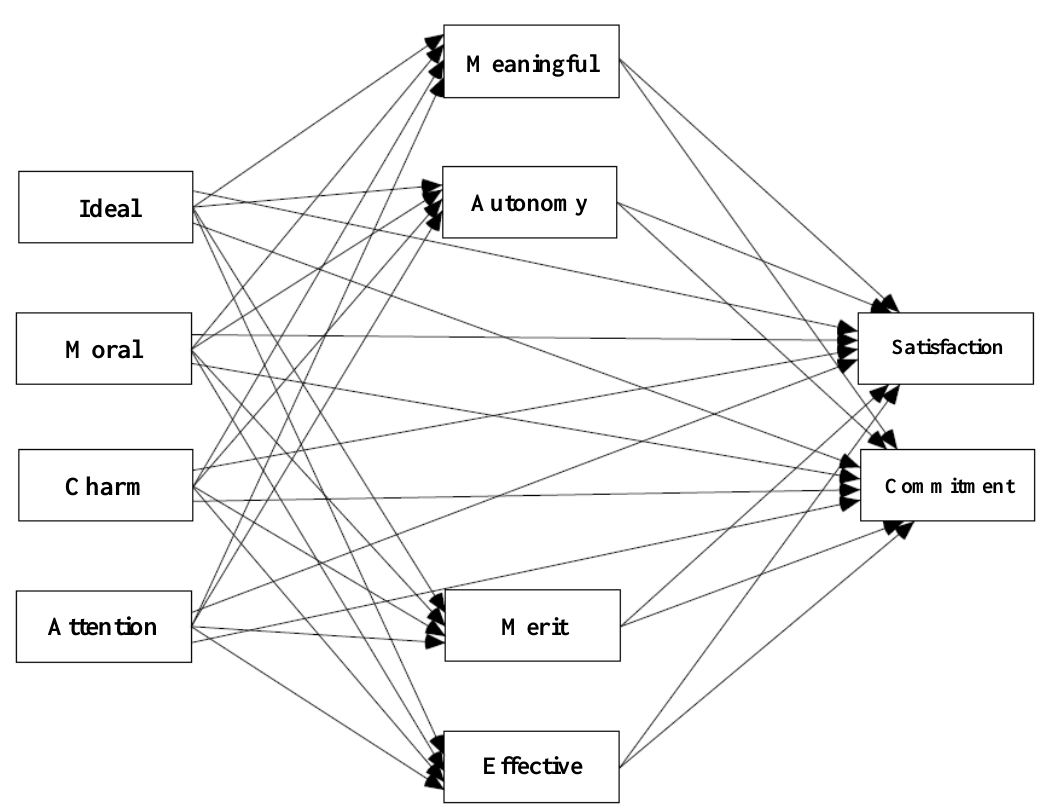
Figure 1. Conceptual model of the research